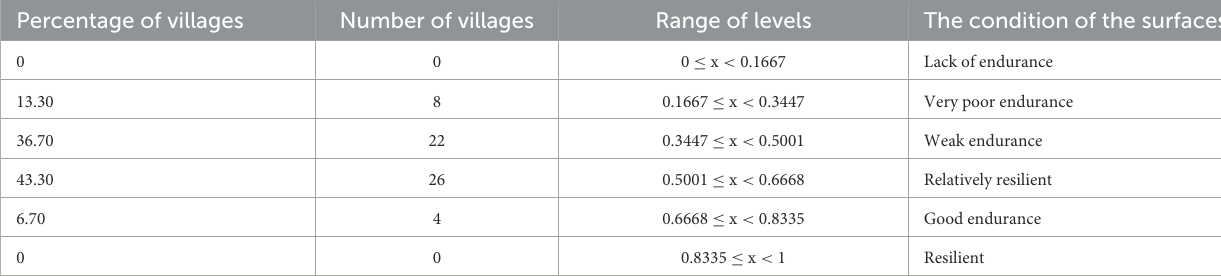
TABLE 10 Zoning of rural areas in terms of the degree of resilience against climate change. Percentage of villages Number of villages Range of